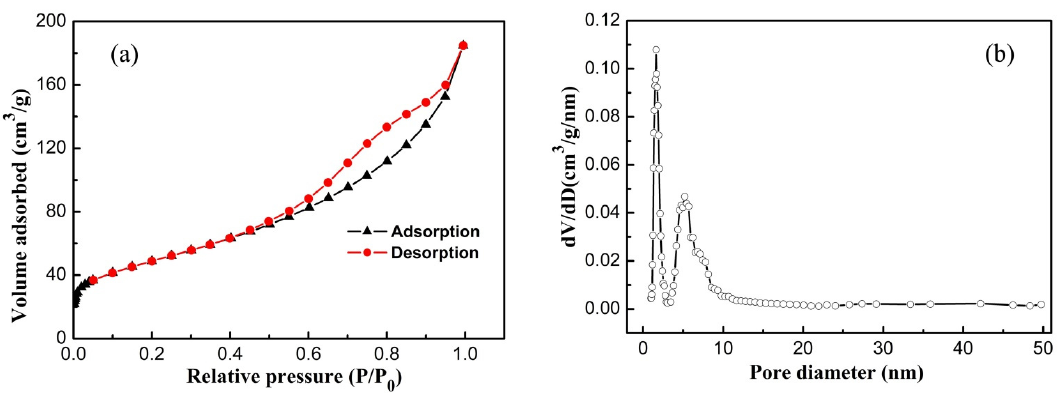
Figure 5. ( a ) The nitrogen adsorption–desorption isotherm and ( b ) the corresponding pore size and distribution curve of SnO 2 − x -105T. distribution curve of SnO 2 − x